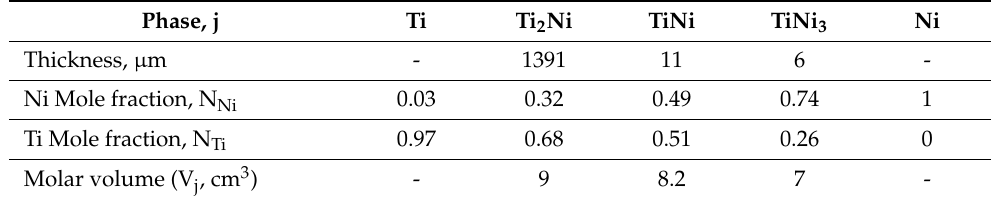
Table 2. Experimental data after annealing of Ti–Ni diffusion couple for 13 h at 1173 K. Phase, j Ti Ti 2